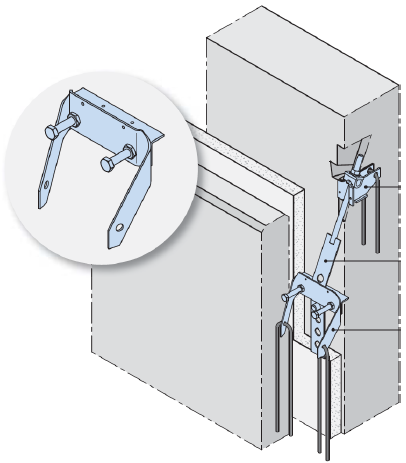
Figure 10. Fixing system for façade panels.